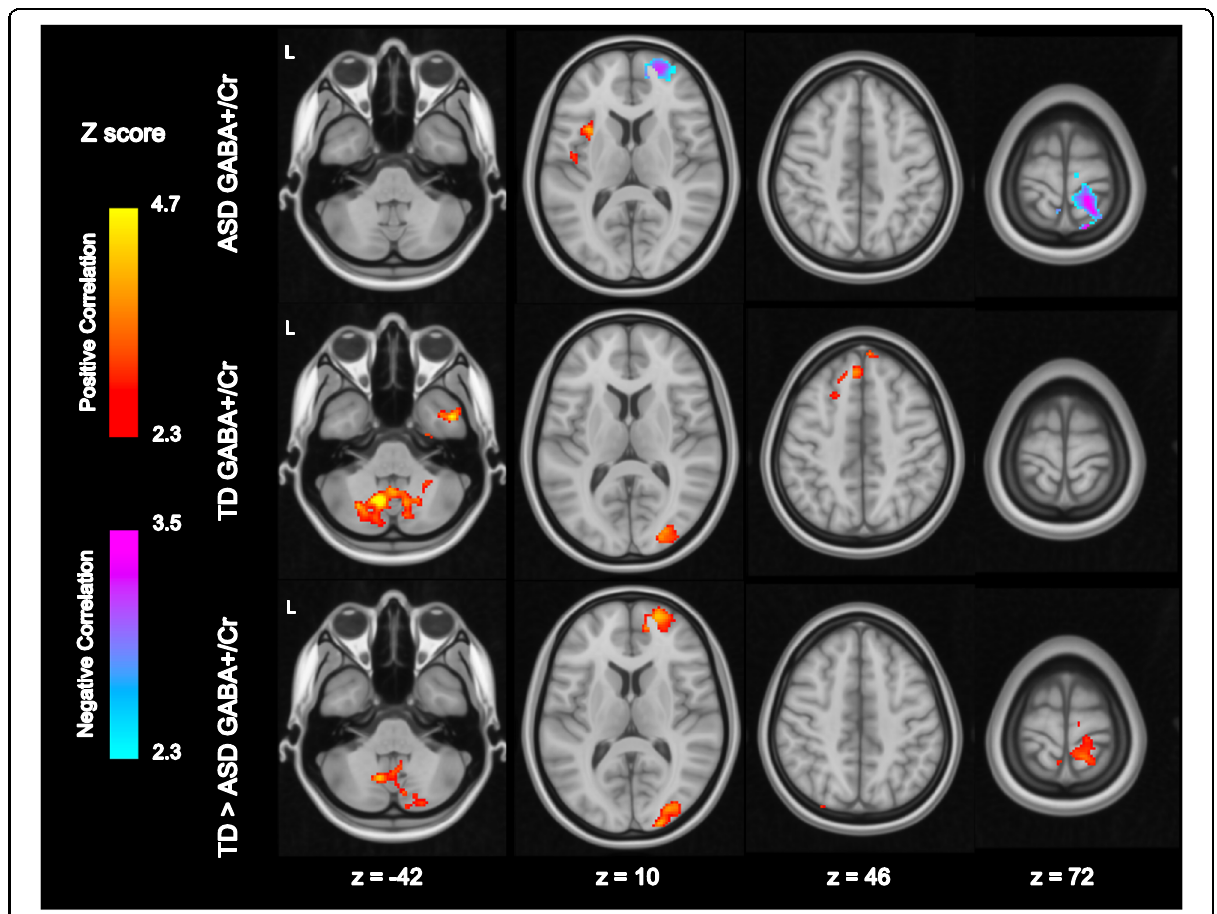
Fig. 2 Thalamus Functional Connectivity Related to Thalamic GABA + /Cr. Whole-brain resting-state analyses using bilateral thalamus seed with GABA + /Cr as a bottom-up regressor. Within-group and between-group contrasts are thresholded at Z > 2.30 and cluster corrected at p < 0.05 (see